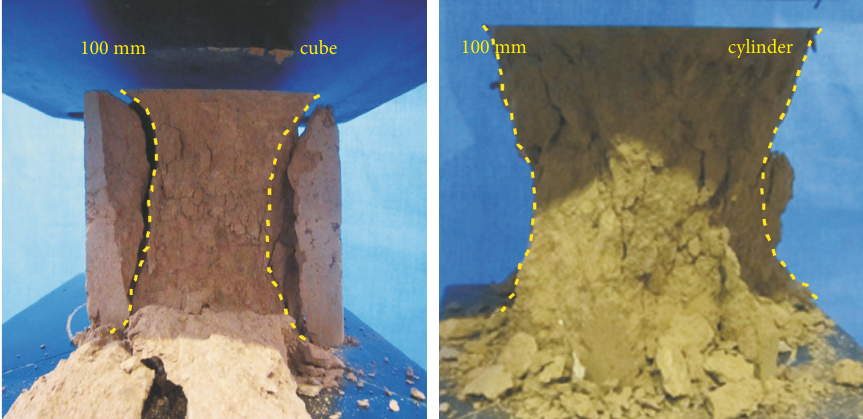
Figure 6: The remaining hourglass core of cube and cylinder.